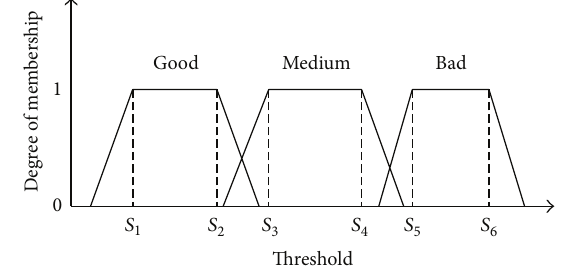
Figure 6: Fuzzy sets of the proposed entries and their trapezoidal membership